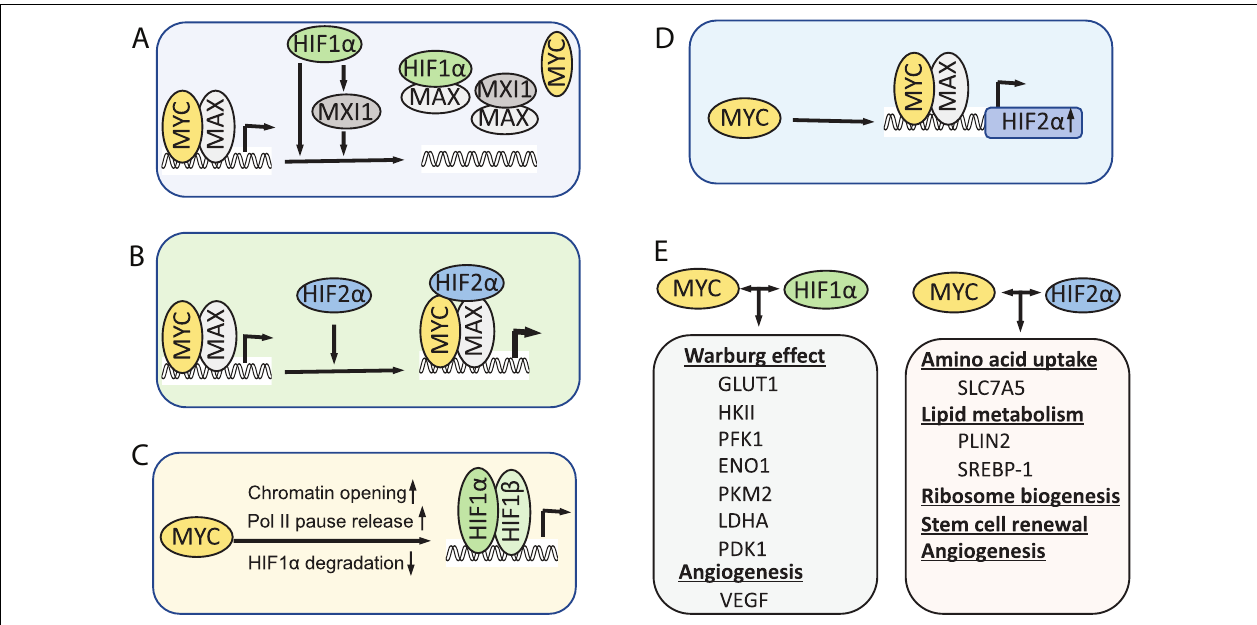
FIGURE 2 | Models for the interplay between MYC and HIF. (A) HIF1 α inhibits MYC activity under hypoxia. (B) HIF2 α promotes MYC activity by stabilizing MYC-MAX complex. (C) MYC, when overexpressed, increases HIF levels and activity. (D) MYC also directly promotes HIF2 α expression. (E) In cancer cells when MYC levels are high, MYC collaborates with HIFs to induce metabolic rewiring, tumor angiogenesis and CSC renewal, thereby promoting tumor cell growth and